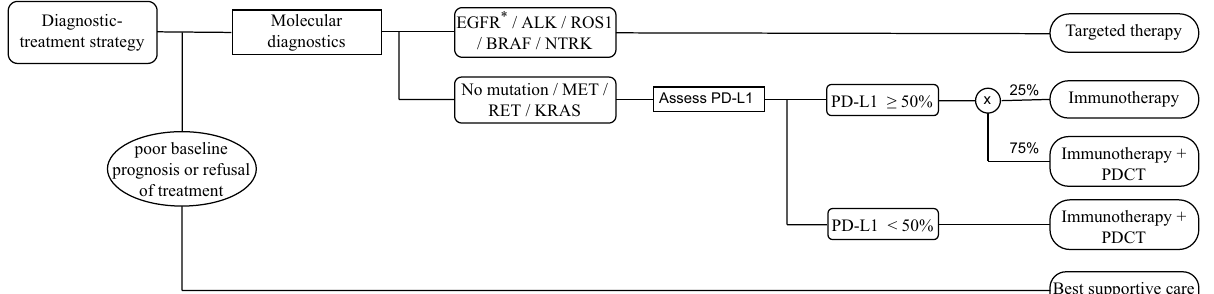
Figure 2. Molecular diagnosis-treatment decision